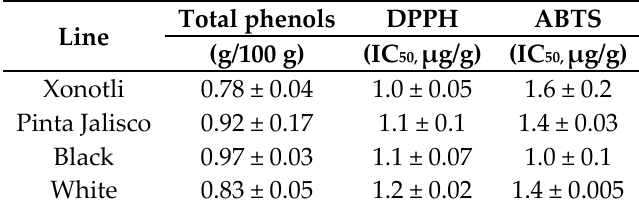
Table 4. Total phenolic compounds and antioxidant capacity in